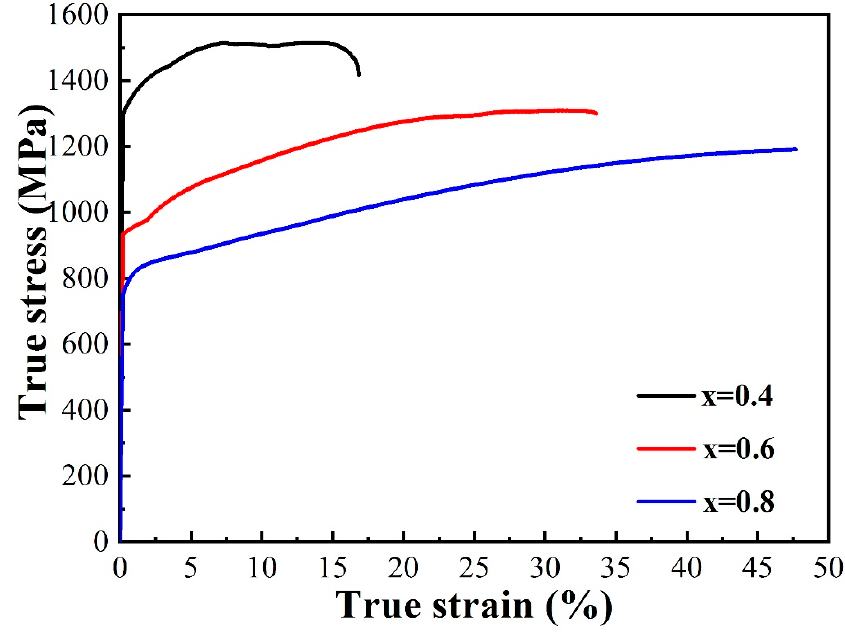
Figure 5. Compressive true stress–strain curves for (TiZr) x (NbTaV) 1 − x ( x = 0.4, 0.6, and 0.8) RHEAs at room temperature.